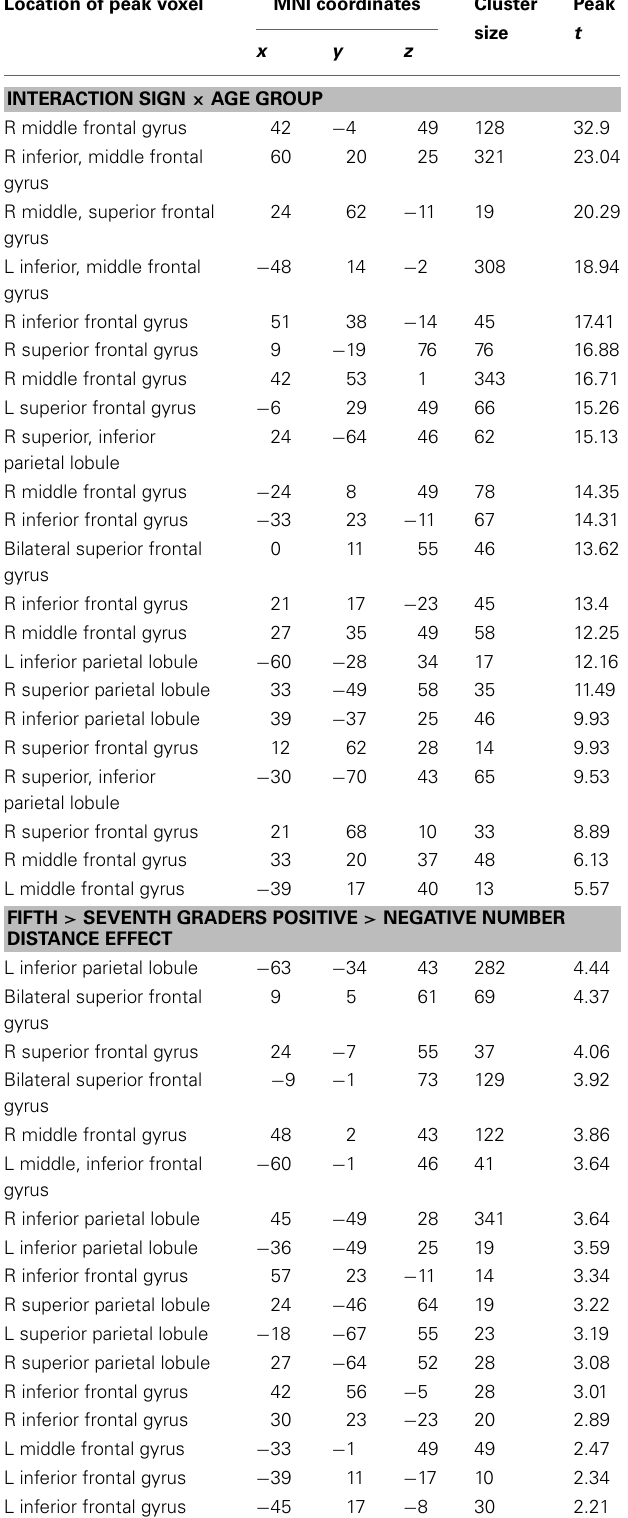
Table 6 | Interaction between sign and age group on the distance effect.